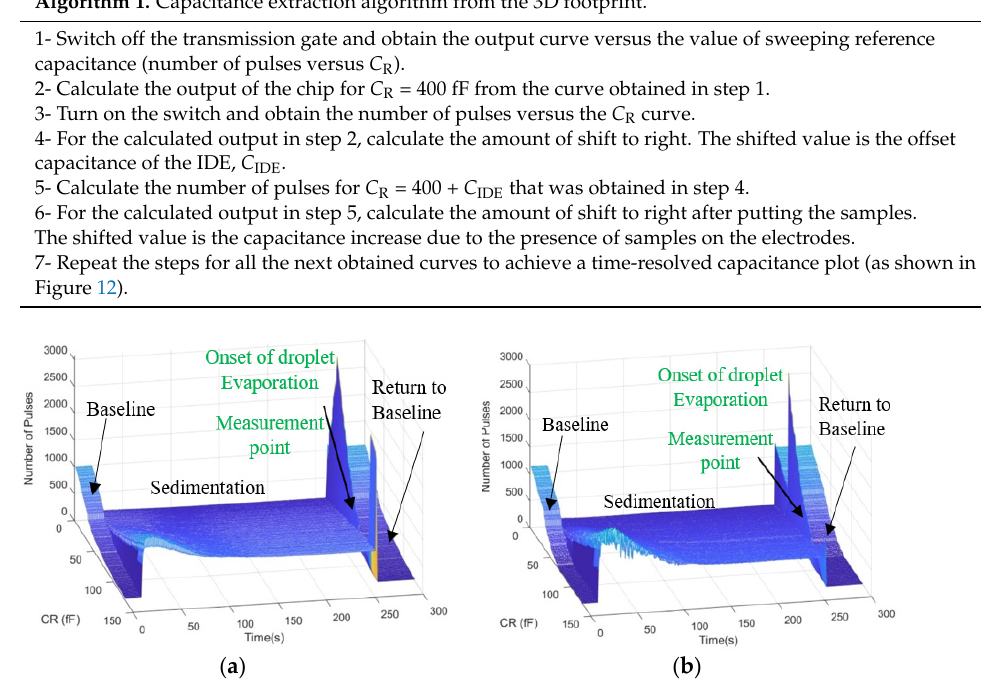
Figure 12a. The GUI generates three commands based on the user settings and sends them to the microcontroller. Then, the serial port is checked again before establishing the measurement command on the serial port. Next, the data is received from the chip and read from the microcontroller’s SPI port buffer.